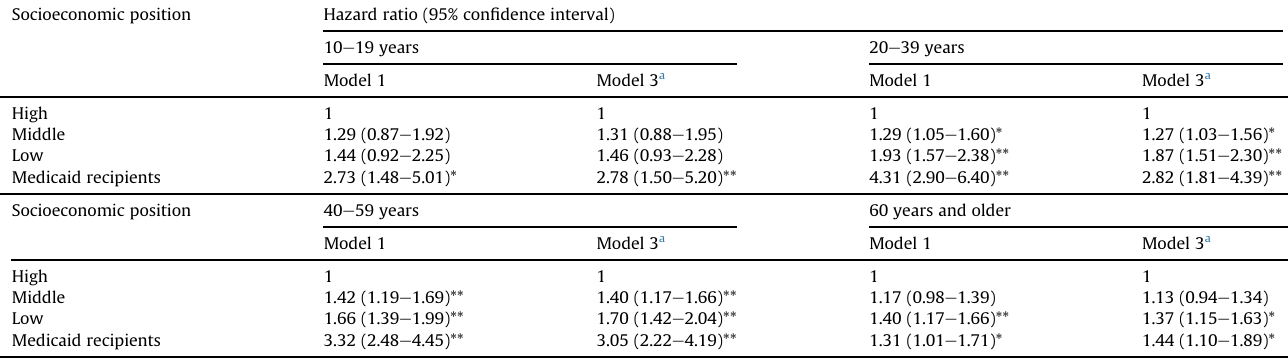
Table 5 Hazard ratios across socioeconomic positions, strati fi ed by age groups. Socioeconomic